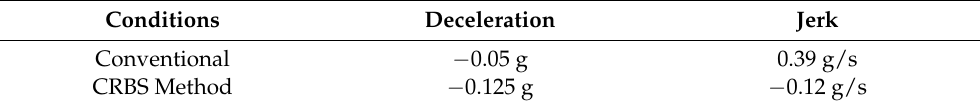
Figure 24. Jerk comparison when changing speed from 30 to 10 km/h. The maximum jerk controlled by CRBS was − 0.12 g/s, and that of the conventional method was 0.39 g/s. Table 3. Comparison of the conventional and CRBS method when vehicle decelerated from 30 km/h to 10